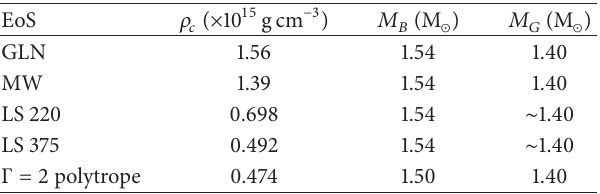
Table 1: Table presenting central density, baryon mass, and gravita- tional mass for the five adopted equations of